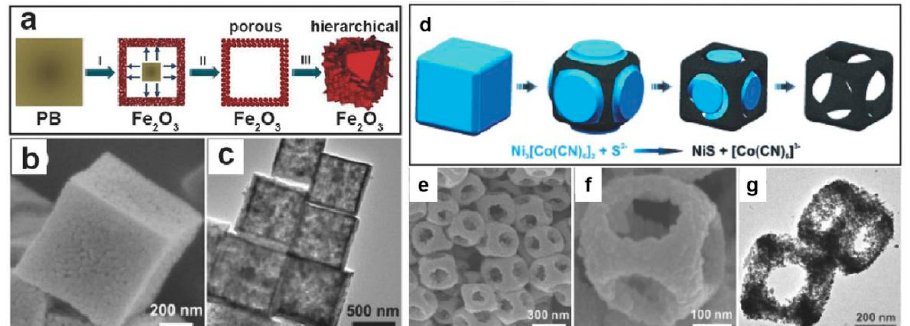
Figure 10. ( a ) Schematic diagram of the fabrication process of Fe 2 O 3 nanoboxes from PB (Step Ⅰ : the formation of Fe 2 O 3 from PB under a large temperature gradient below 350 °C along the radical direction; Step Ⅱ : Annealing at 550 °C; Step Ⅲ : the transformation of porous shell structure into hierarchically structure shell consisted of Fe 2 O 3 nanosheets.); ( b ) FESEM images of the Fe 2 O 3 nanoboxes; ( c ) TEM of the Fe 2 O 3 nanoboxes; ( d ) schematic diagram of the fabrication process of NiS nanoframes from NiCo-PBA; ( e , f ) FESEM of the NiS nanocages; and ( g ) TEM of the NiS nanocages. ( a – c ) Copied